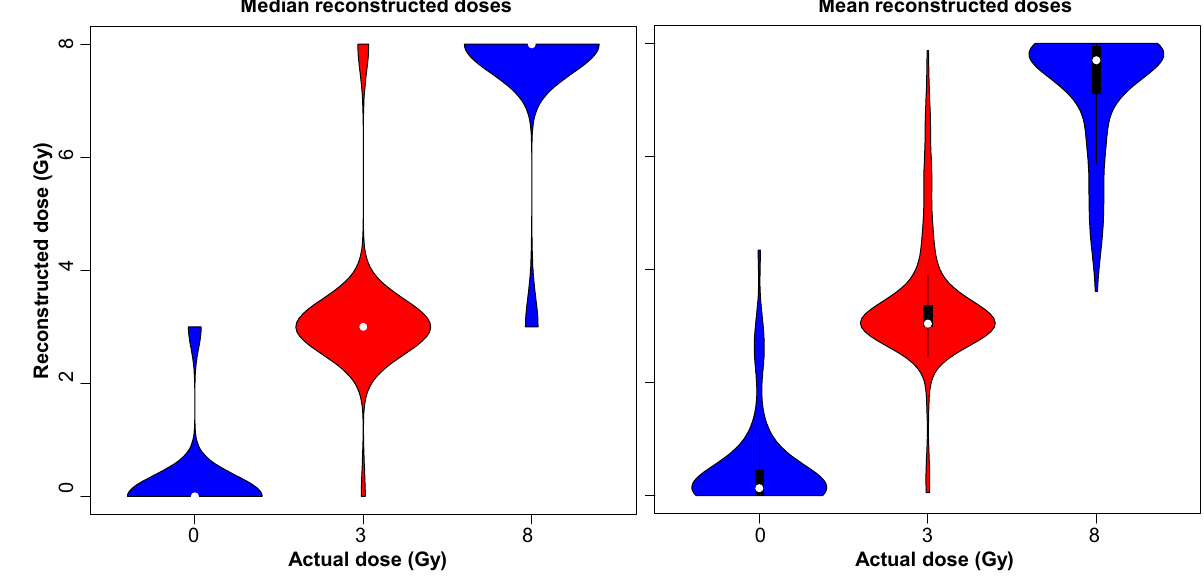
Figure 4. Visualization of actual and reconstructed radiation doses. The reconstruction was performed by the random forest algorithm on the testing half of the data set. The left panel shows median dose predictions, generated using quantile random forest, and the right panel shows mean dose predictions. The violin plots for 0, 3 and 8 Gy show the distributions of corresponding reconstructed dose values. The model’s performance metrics were: R 2 for actual vs. reconstructed doses = 0.845, RMSE = 1.160 Gy and MAE = 0.628 Gy. The median reconstructed doses which corresponded to actual doses of 0, 3 and 8 Gy were 0.132, 3.043 and 7.700,